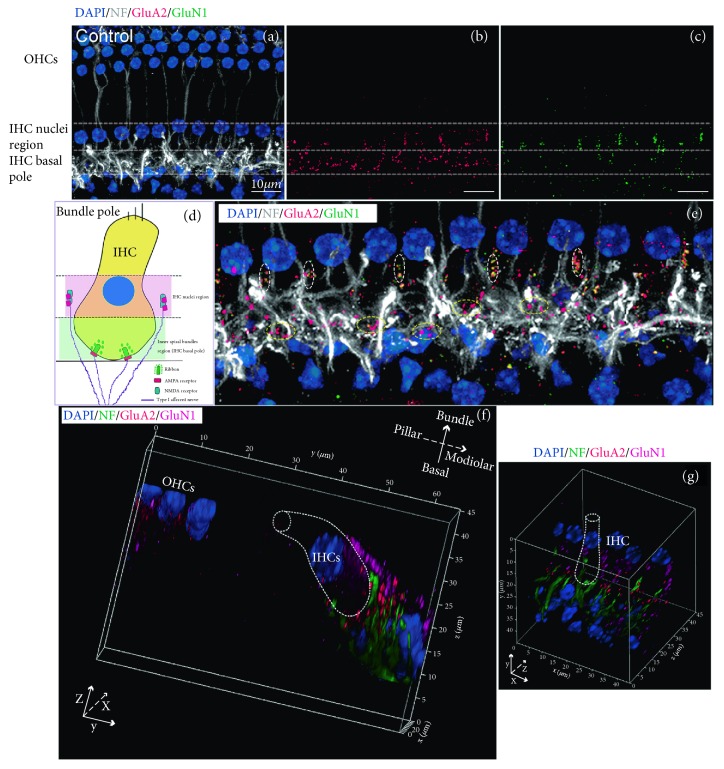
The different distributions of NMDARs and AMPARs at afferent dendritic terminals around IHCs in the normal mature cochlea. Postsynaptic AMPARs, NMDARs, and nerve fibers were identified by immunostaining for GluA2 (red), GluN1 (green), and neurofilament (NF) (grey), respectively. Nuclei were labeled with DAPI (blue). (a) The ISBs appeared as a dense meshwork of neuronal processes at the basal pole region of the IHCs. (b) AMPAR patches were mostly distributed among the ISBs around the basal poles of the IHCs. (c) Most of the NMDAR patches were distributed on the neural dendritic terminals, which were near the IHC nuclei region. (d) A diagram of the different locations of NMDARs and AMPARs at type I ANFs under physiological conditions. To count the number of synaptic elements, we drew one line along the top of the IHC nuclei and another line along the bottom of the ISBs. Then the field between these two lines was divided into two parts, the “IHC nuclei region” and the “IHC basal pole region.” The IHC nuclei region was defined as the half region proximal to the nuclei and the bundle poles of the IHCs, and the IHC basal pole region was defined as the half region proximal to the ISBs and the basal poles of the IHCs. (e) Enlarged view of merged images (a), (b), and (c). Most of the NMDAR patches were distributed on the neural dendritic terminals between the adjoining IHCs and closer to the IHC nuclei region, while most of the AMPAR patches were observed among the ISBs around the basal poles of the IHCs. In the IHC nuclei region, some NMDARs colocalized with GluA2-positive AMPAR puncta (the dashed white circles), which were smaller than AMPAR patches in the IHC basal pole region (the dashed yellow circles). (f, g) The 3D-reconstructed images showing spatial distributions of AMPARs and NMDARs in SGN fibers around the IHCs. Postsynaptic AMPARs, NMDARs, and nerve fibers were identified by immunostaining for GluA2 (red), GluN1 (magenta), and NF (green), respectively. Nuclei were labeled with DAPI (blue). IHC: inner hair cell; OHC: outer hair cell; ISBs: inner spiral bundles; ANFs: afferent nerve fibers. Scale bar = 10 μm.